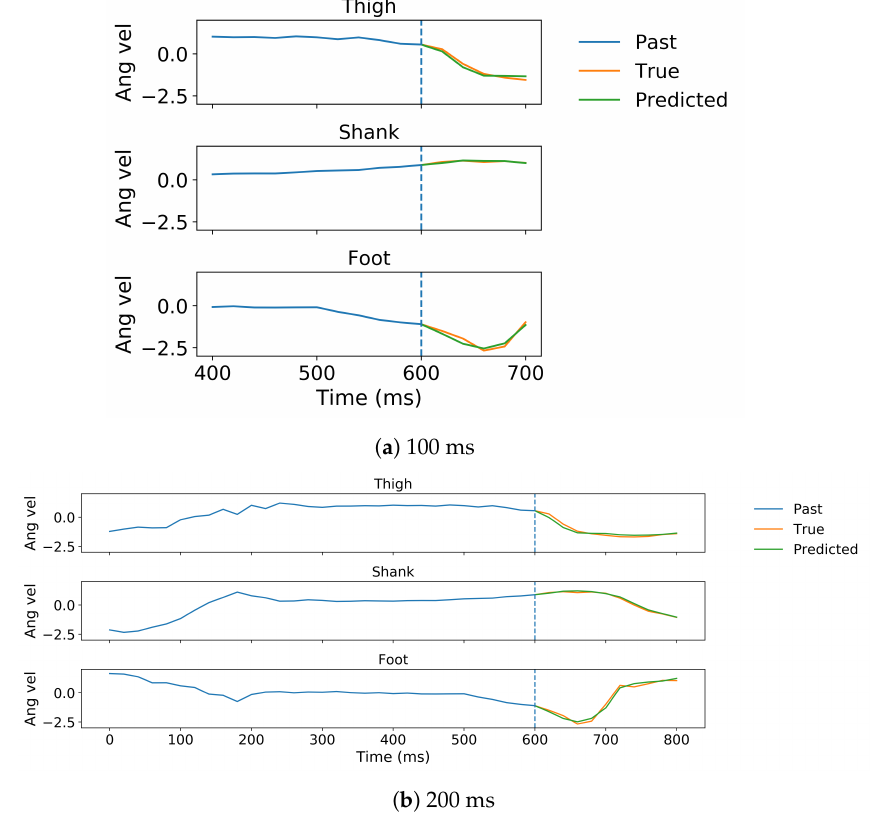
Figure 5. The 100 ms ( a ) and 200 ms ( b ) ahead predictions for z-score normalized angular velocities of ipsilateral thigh, shank and foot of one representative subject in the intra-subject implementation, shown for prediction from the same point in time. All angular velocity values shown are normalized to have zero mean and unit variance. The predicted trajectory is shown in green and the true in orange. Note that more past data are used for the 200 ms ahead prediction than for the 100 ms ahead